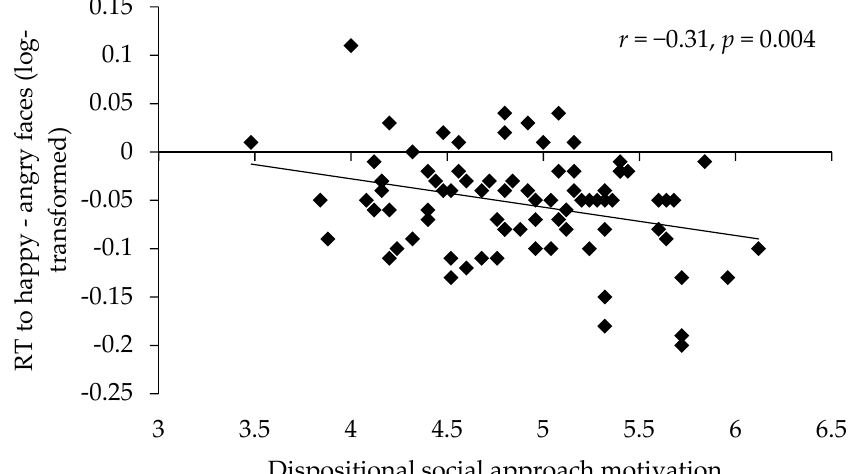
Figure 4. Bivariate correlation between habitual social approach motivation and the reaction-time difference between approach reactions to happy and avoidance reactions to angry faces (Study 3). Positive values represent slower reactions to happy than to angry faces, negative values represent faster reactions to happy than to angry faces.